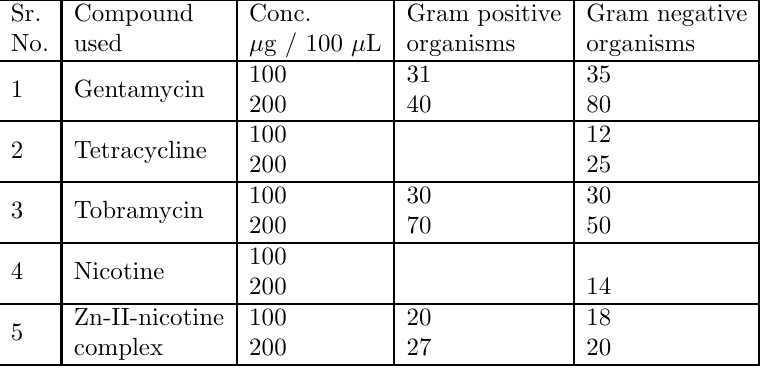
Table 5. Antimicrobial activity of Zn-II-nicotine complex Sr. Compound No. used